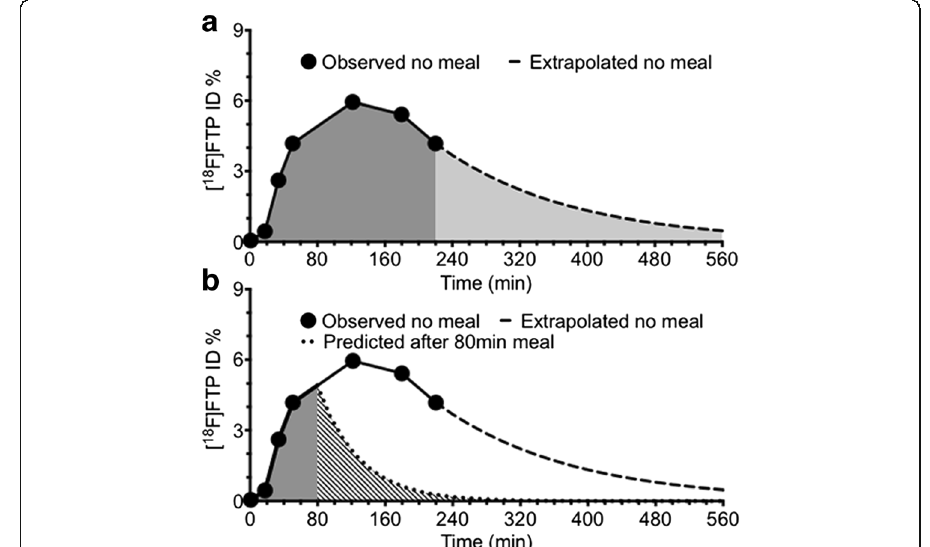
Fig. 3 Subject 8 ’ s gallbladder dose without a meal ( a ) and simulated dose with a fatty meal ( b ). Legend: Example of the gallbladder dose in an individual volunteer without a fatty meal ( a ) and simulated gallbladder dose for the same patient after consumption of a fatty meal at 80 min to match this subject ’ s intervention consumption time ( b ) where the extrapolated no meal curve is based upon an exponential decay fit to the last two experimental data points. The dark gray area under the curve represents experimentally collected data, whereas the light gray shaded area in a represents the predicted portion of the dose. The striped area under the curve in b illustrates the predicted dose using the fatty meal simulation. Difference in total shaded areas under the curve in a and b represent a change in dose received by the gallbladder with the addition of a fatty meal